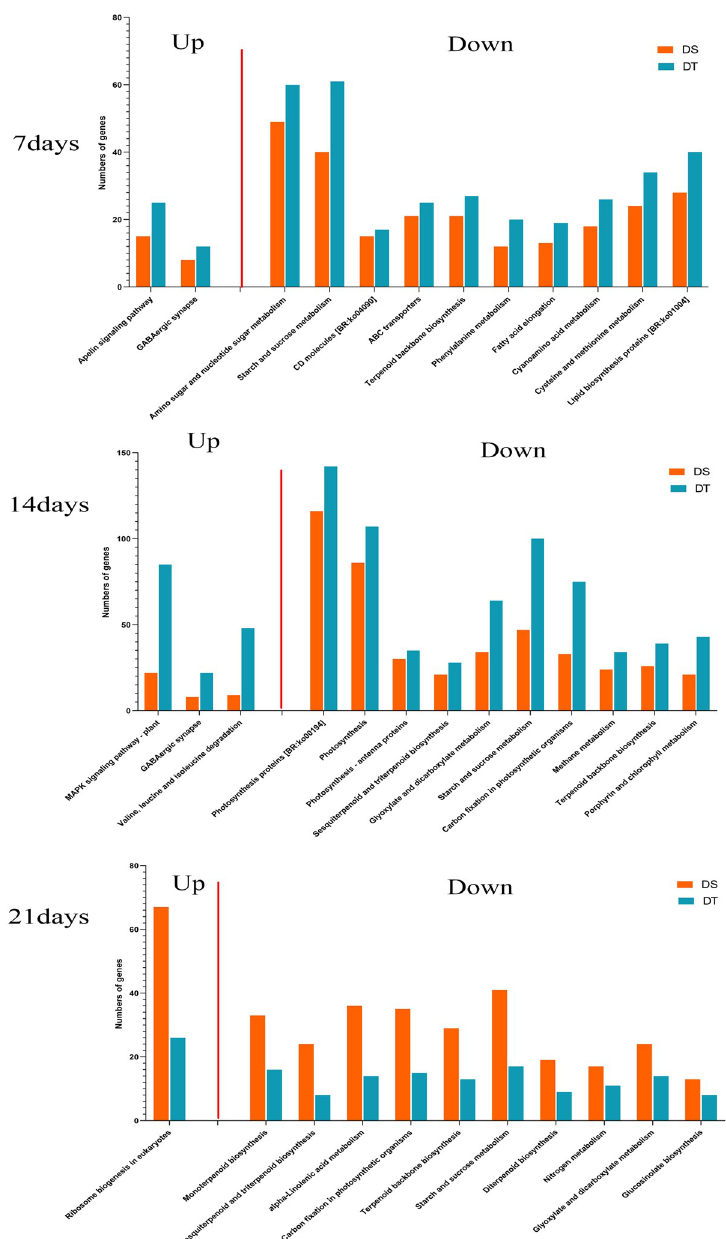
Fig 5. Pathway analysis for significant DEGs. Graphical representation of number of DEGs enriched in common KEGG pathways in DS comparative to DT at all three-time